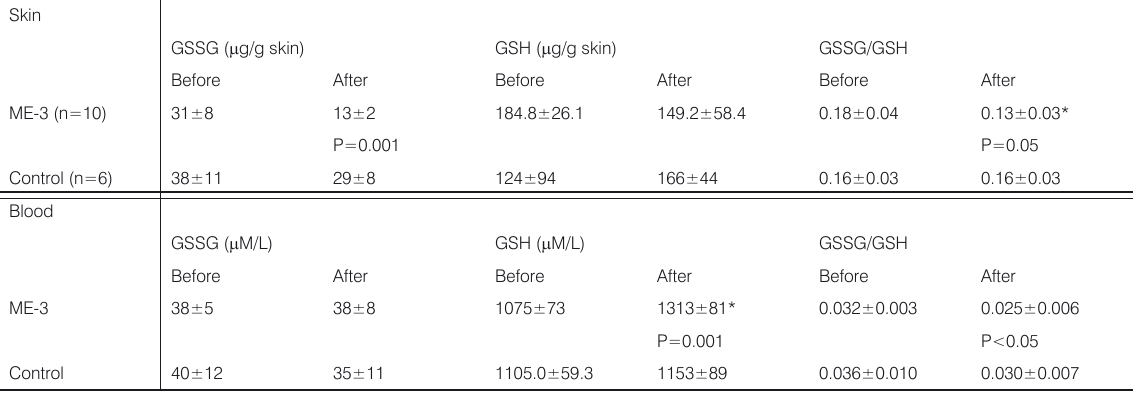
Table 1. The glutathione status and redox ratios of the skin and